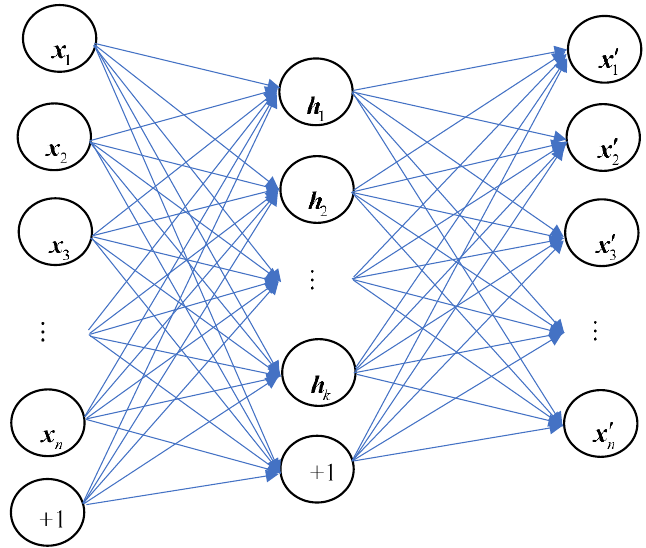
Figure 1. The structure of an autoencoder (AE).